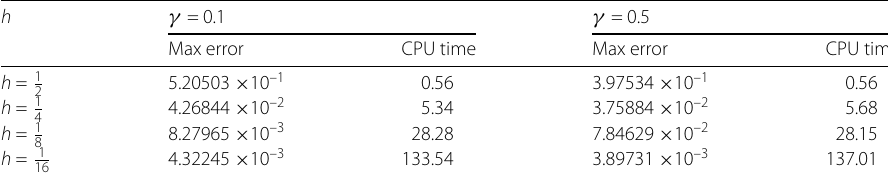
for Example 1 20